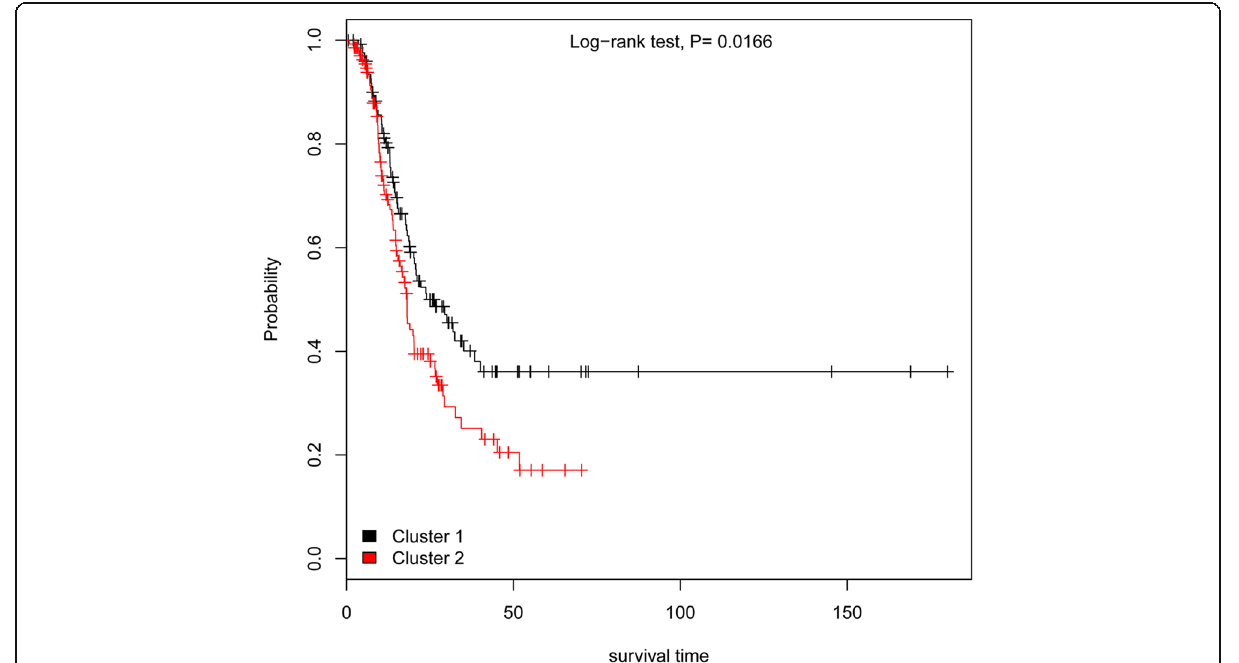
Fig. 6 Survival curve of cluster 1 and cluster 2, based on the ANN model. cluster1 represents the low-risk group, whereas cluster 2 represents